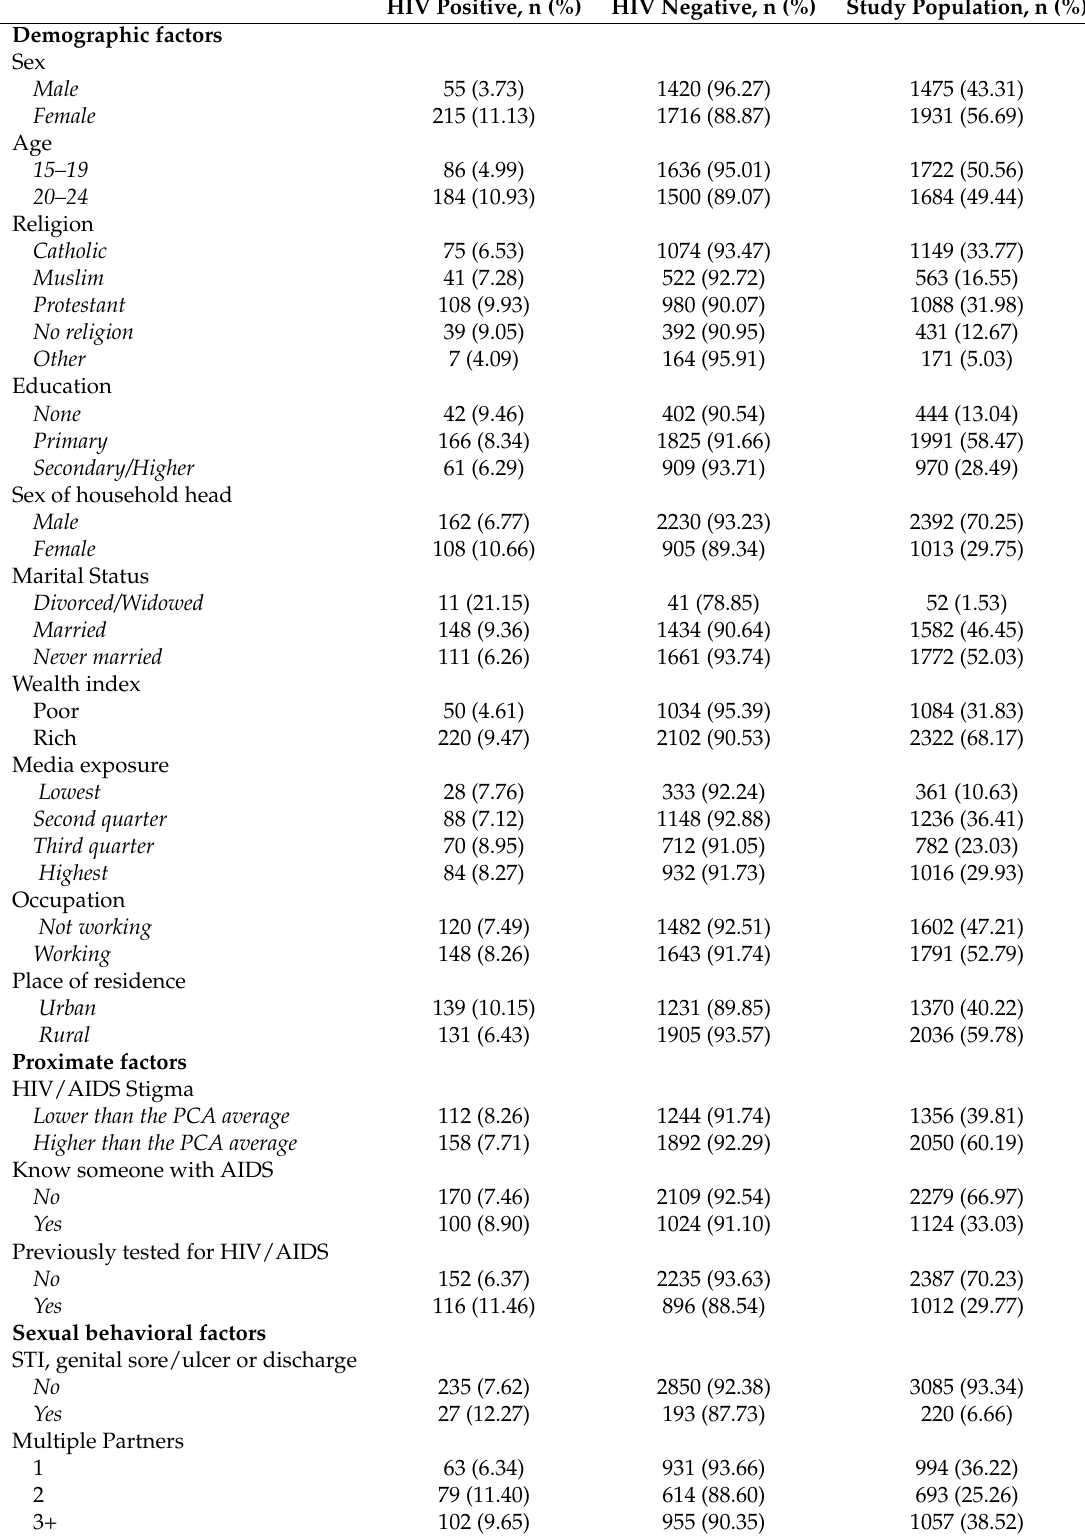
Table 2. Distribution of HIV prevalence by demographic factors. PCA: principal component analysis; STI: sexually transmitted